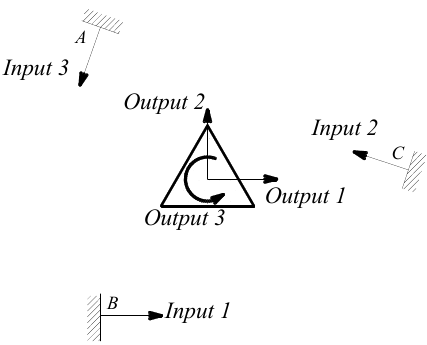
Figure 3. 3-PRR planar fully CPMs topology optimization with load case.